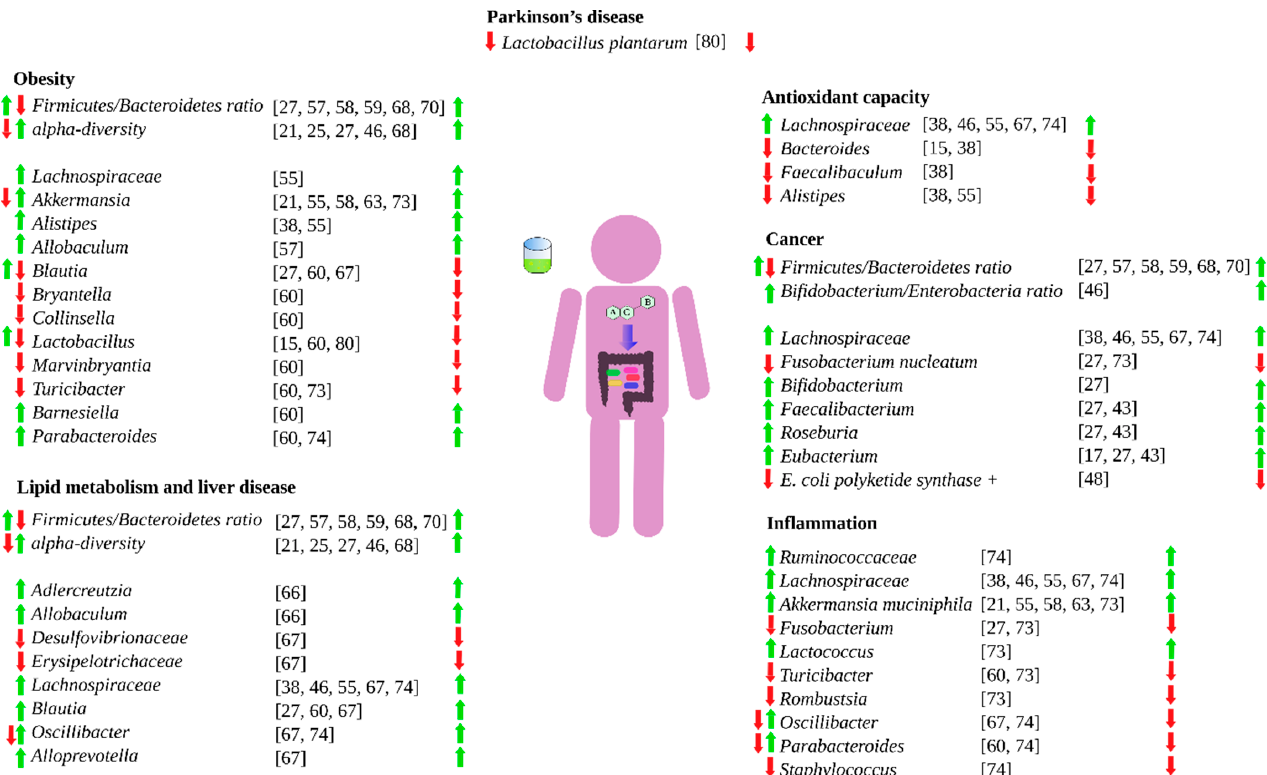
Figure 2. Influence of green tea on different health aspects via gut microbiota. Left-hand arrows means that green tea either favors (green) or hinder (red) the specific bacteria growth. Right-hand arrows means that the bacteria effect is either beneficial (green) or detrimental (red).